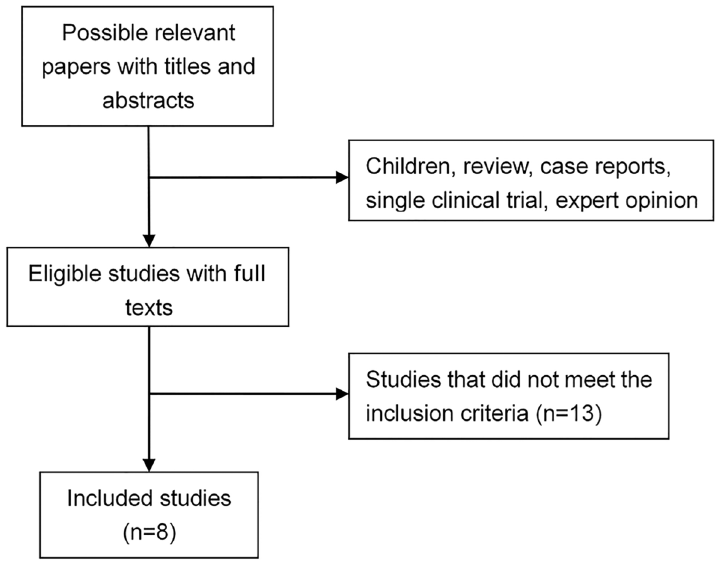
Figure 1. Study selection